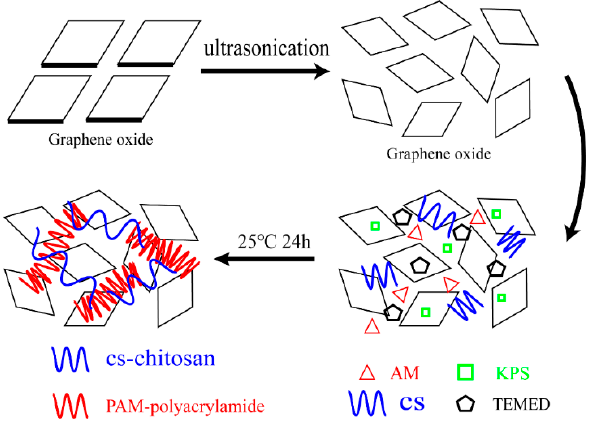
Figure 1. Synthetic process of CAG nanoparticles.